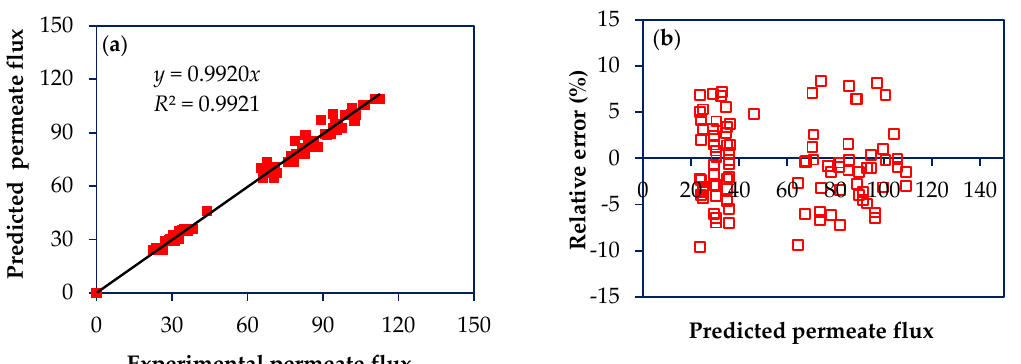
Figure 5. Scatter diagram for permeate flux data external to the model. ( a ) Plot of predicted permeate fluxes vs. experimental permeate fluxes; ( b ) Plot of relative error as a function of predicted permeate flux. Permeate fluxes are given in kg h −1 m −2 .